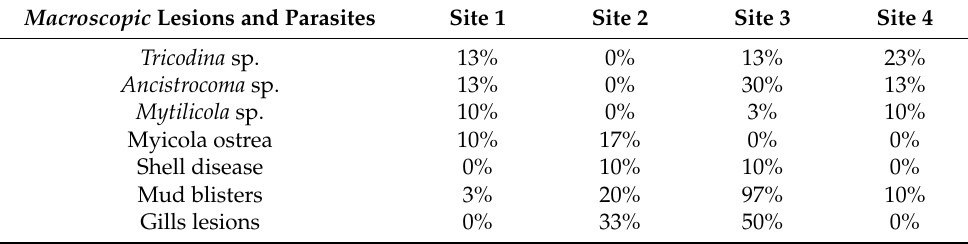
Table 1. Prevalence of macroscopic lesions and parasites in different populations. Macroscopic Lesions and